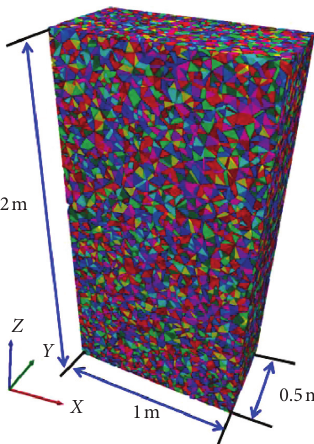
Figure 3: Sample model for UCS and direct tension tests.